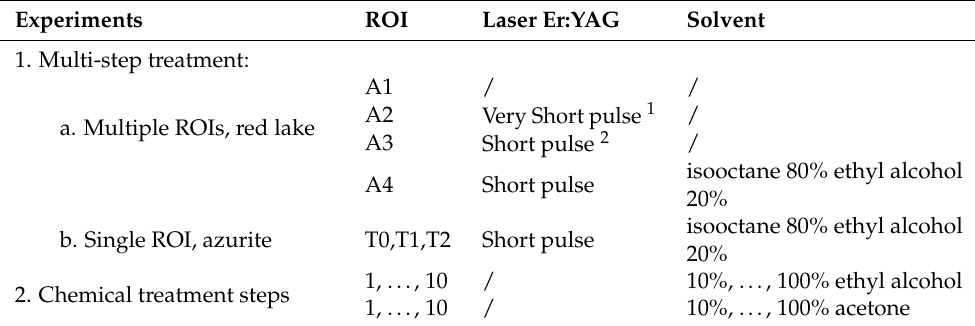
Table 1. Description of the surface treatment samples.